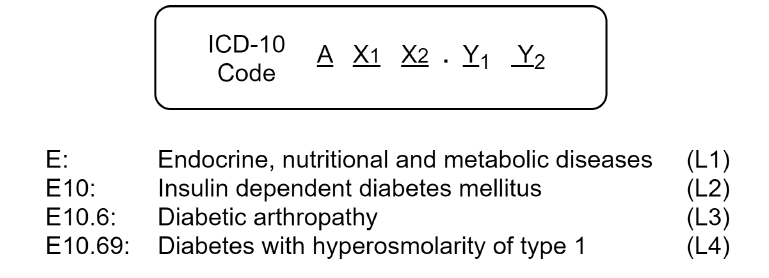
Figure 3. ICD-10 code structure with second through fourth layer representations and diabetes as an